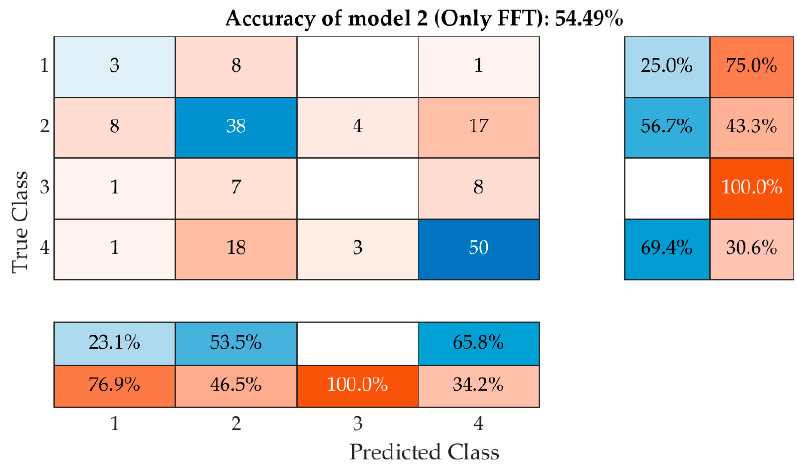
Figure 18. A model with only FFT parameters is known without absorbability.